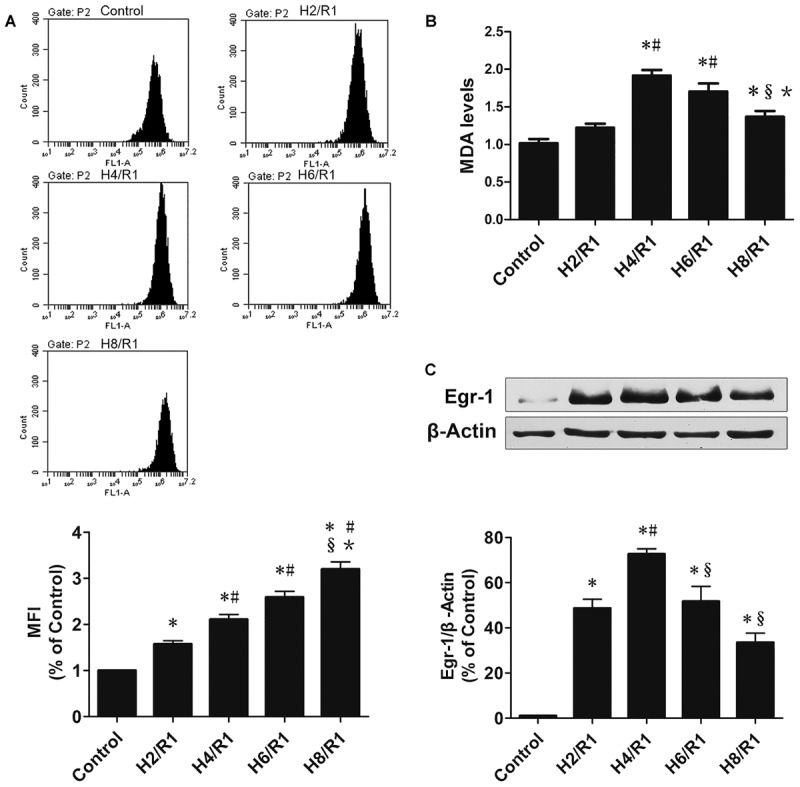
Reactive oxygen species (ROS) and MDAs and Egr-1 protein expression in H9c2 cells at various times following H/R. (A) ROS s determined by flow cytometry, n = 3. (B) Level of MDA, n = 6. (C) Representative Egr-1 western blot and quantitation of Egr-1 protein expression by western blotting analysis, n = 3. All values are means ± SEM.; ∗p < 0.05 vs. control group; #p < 0.05 vs. H2/R1 group; xp < 0.05 vs. H4R1 group; ∗p < 0.05 vs. H6/R1 group.